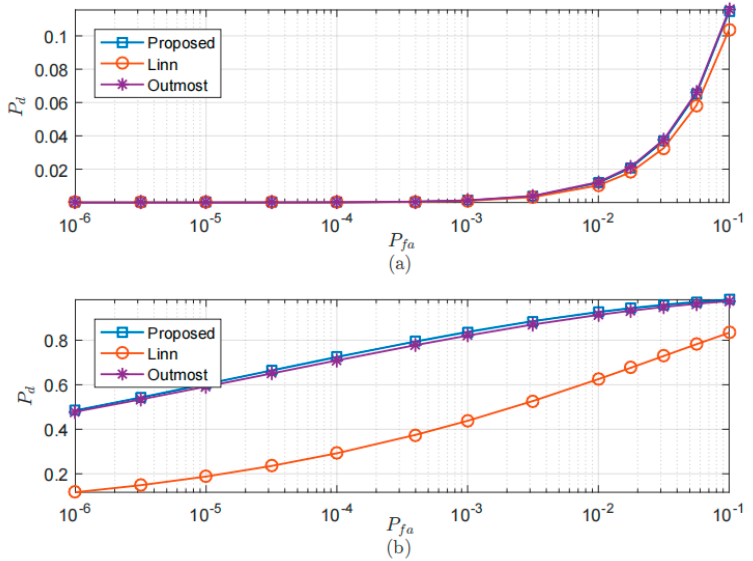
Figure 9. ROC curves of the 32APSK signal carrier synchronization lock detector at two different SNRs: ( a ) E s / N 0 = 7.2397dB( b ) E s / N 0 =